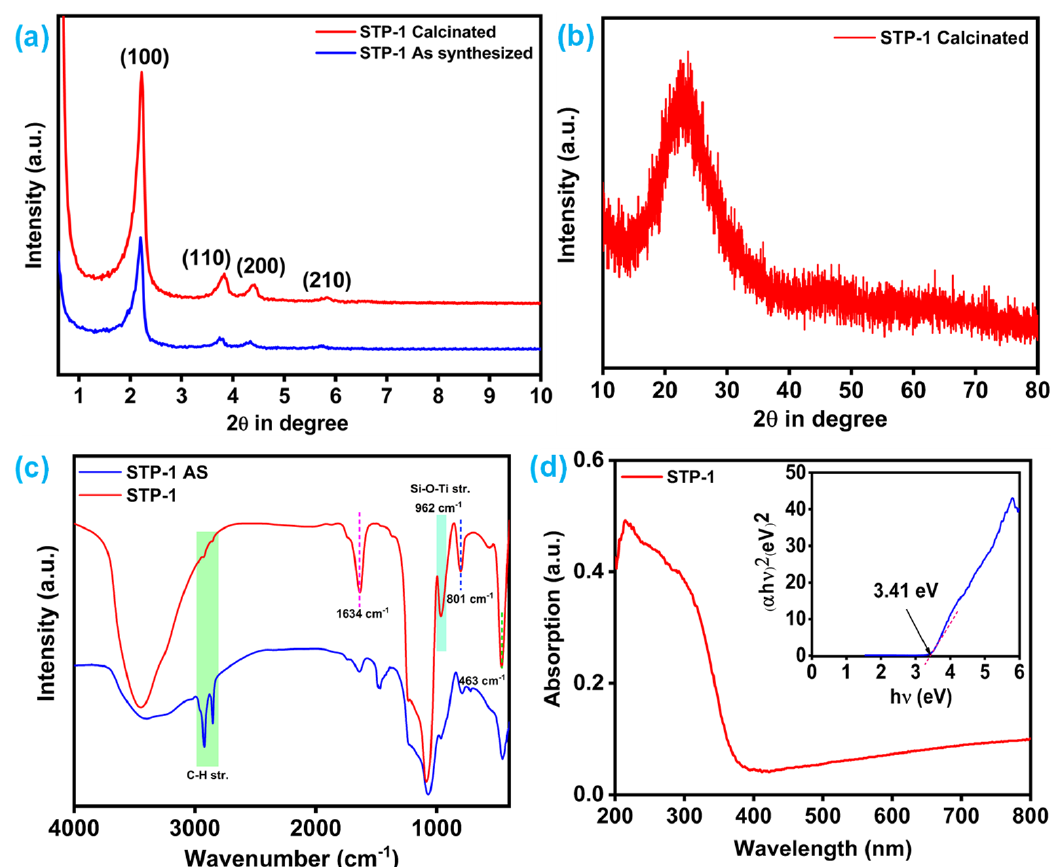
Figure 1. ( a ) Small-angle powder XRD pattern of the as-synthesized and calcinated STP-1; ( b ) wide-angle powder XRD pattern of the calcinated STP-1 material; ( c ) FT-IR spectra of the as-synthesized (blue) and calcinated (red) STP-1; ( d ) UV-Vis DRS data of STP-1 (Tauc plot as the inset).